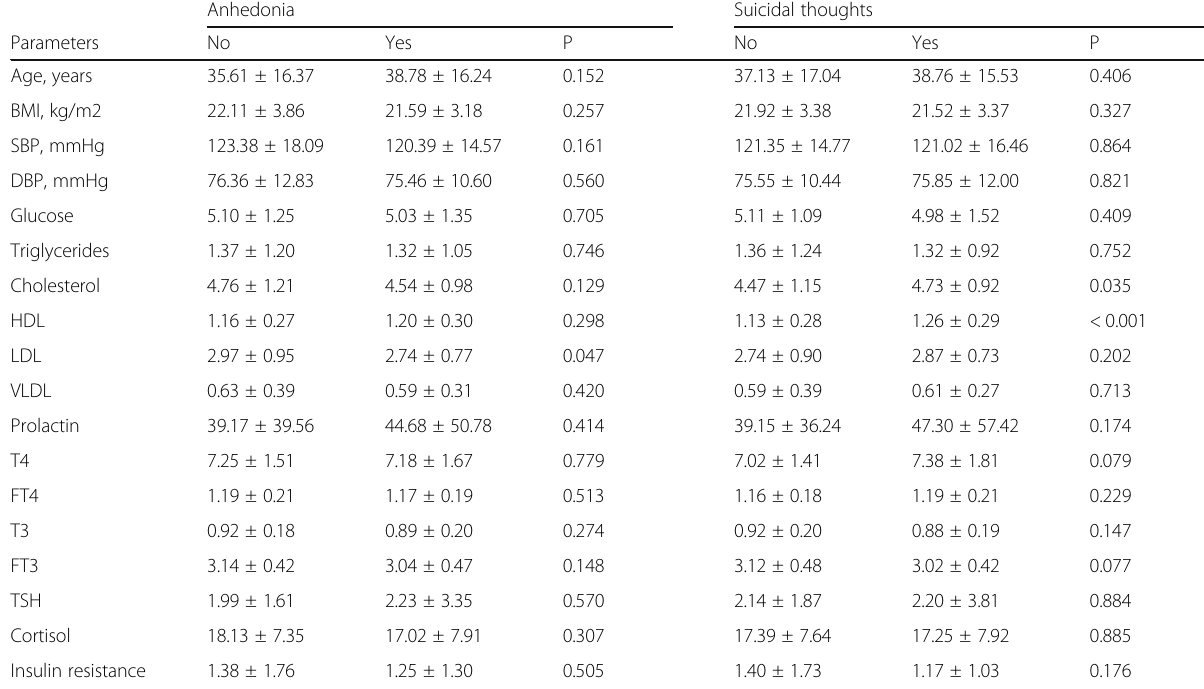
Table 2 Grouped comparisons in each psychological index Anhedonia Suicidal